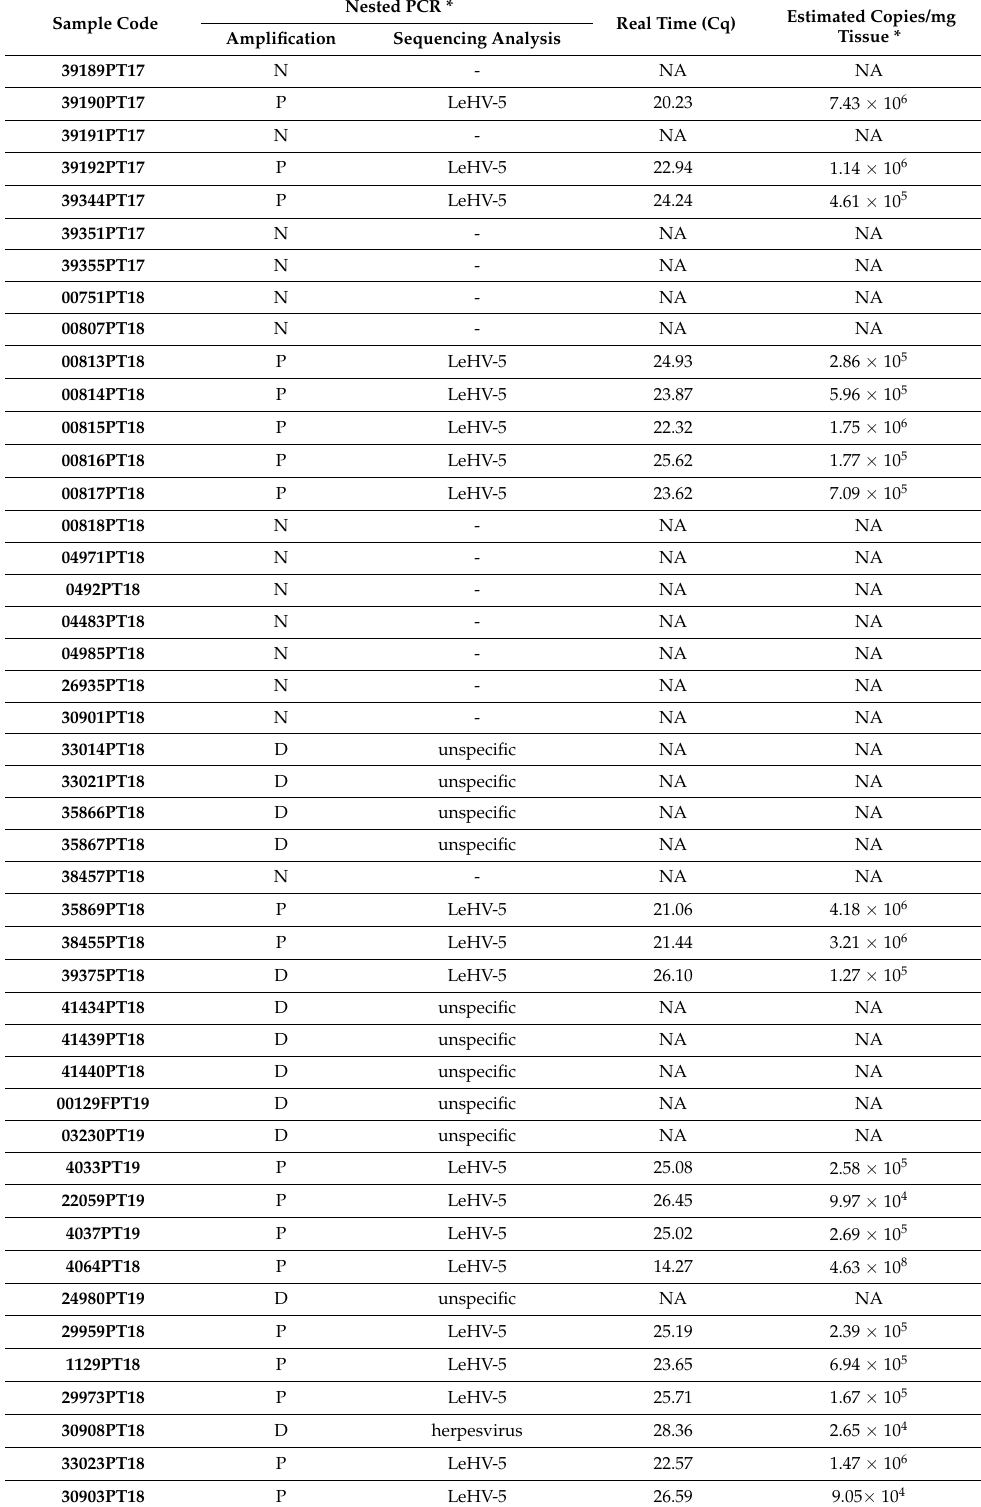
Table 4. Comparative final diagnosis between Nested PCR [11] and Taqman rt-qPCR system. Sample